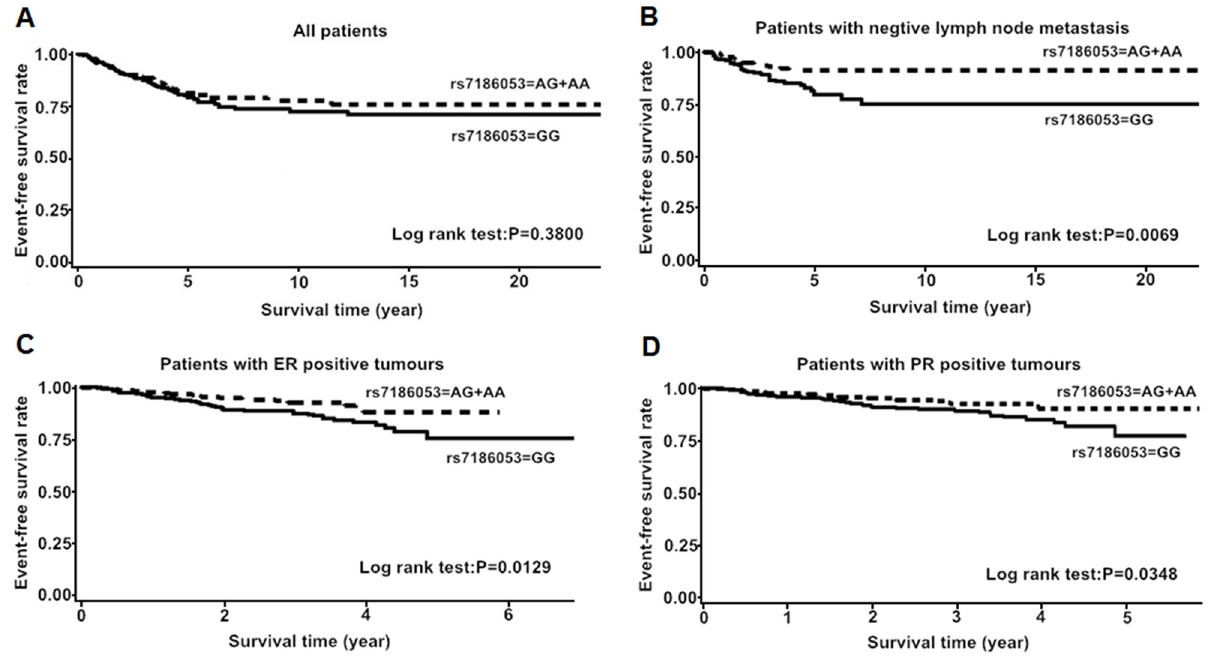
Fig 3. Kaplan-Meier estimates of event-free survival according to rs7186053 genotypes. A: among all breast cancer patients; B: among patients without lymph node metastasis; C: among patients with ER-positive tumors; D: among patients with PR-positive tumors. P values were calculated by log rank test.